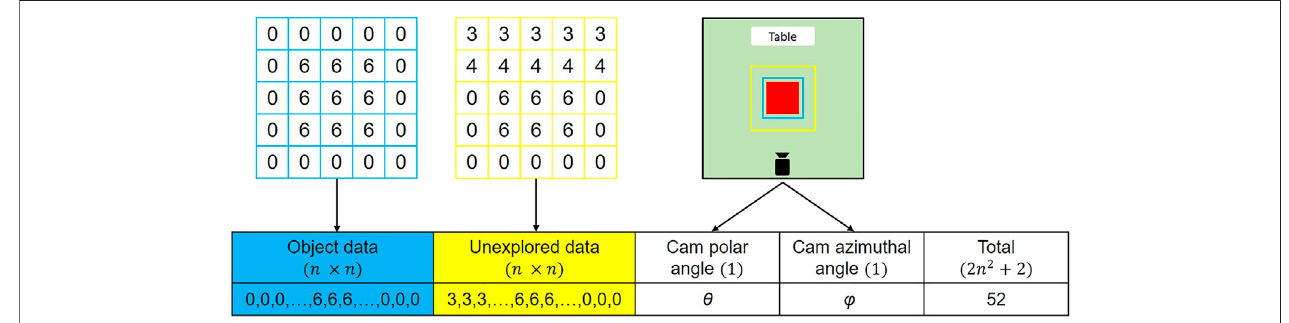
FIGURE5| HAFbasedstatevectorfora6 × 6 × 6 cmcubeonthetable.Thebluesquareshowsthesquarezoneconsideredforobjectdataandtheyellowsquare shows the zone considered for unexplored data. The length of the unexplored data square zone is 1.5 times that of the object square zone. The values represent the maximum height among the points within each grid. These data are fl attened and merged along with camera information for generate the state vector.